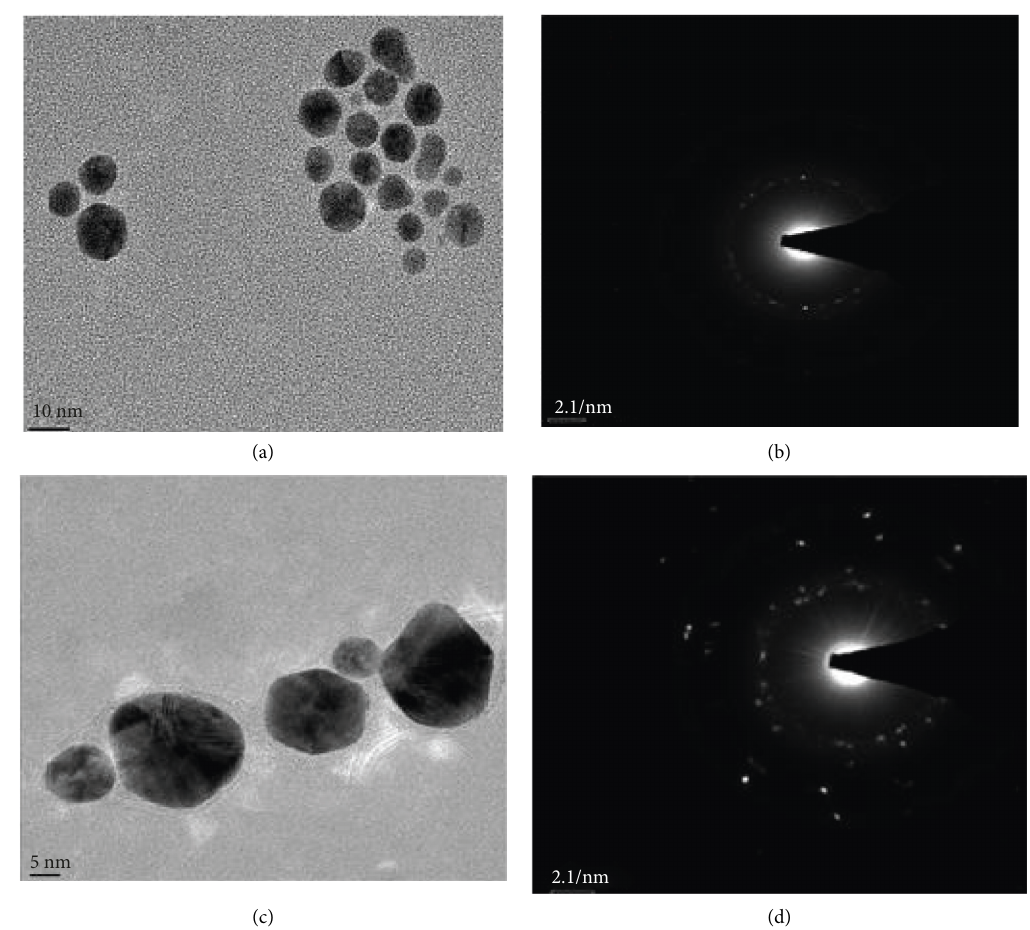
Figure 4: The TEM images and the SAED for room temperature synthesis (a, b), as well as synthesis at 85 ° C (c,